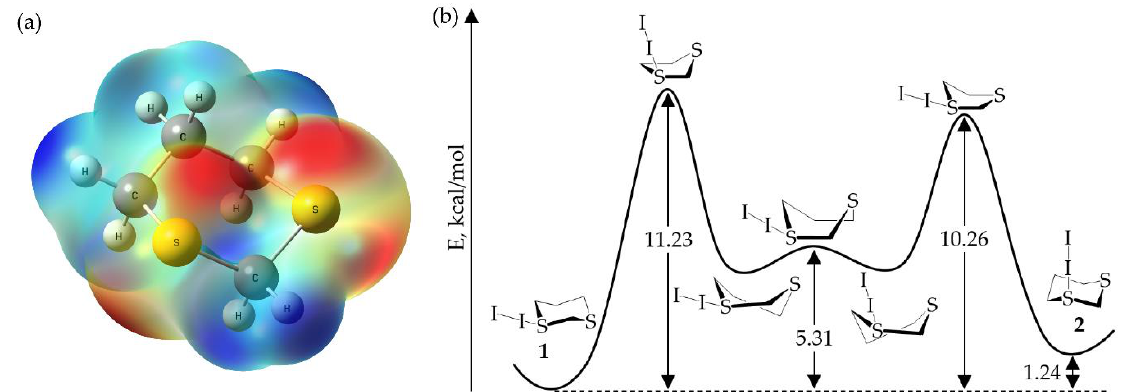
Figure 3. Electrostatic potential (ESP) map of 1,3-dithiane ( a ) and reaction coordinate of the ring flip from 1 to 2 ( b ). The electrostatic potential is calculated at the 0.005 au isodensity surface and ranges from − 25 kcal/mol (red) to 38 kcal/mol (blue).